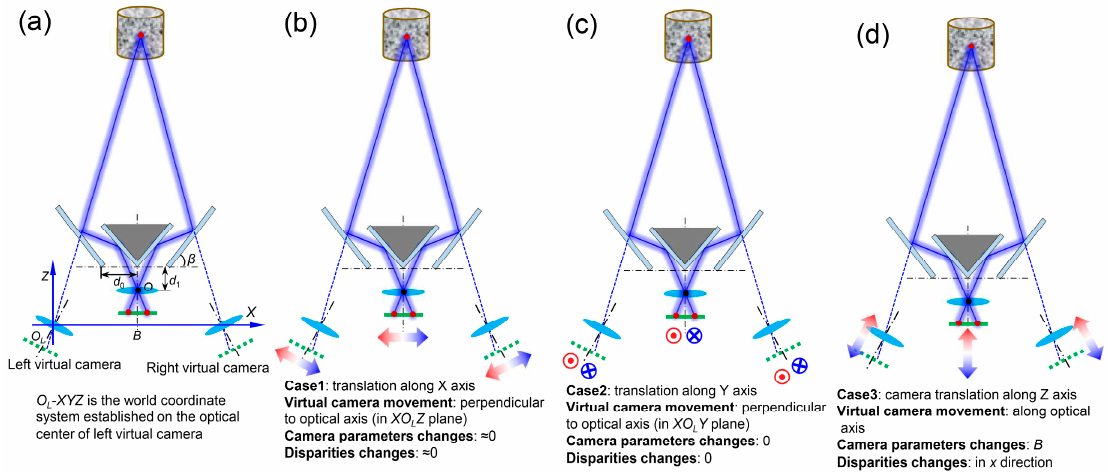
Figure 7. ( a ) Schematic diagram of the smartphone-based stereo-DIC system and ( b–d ) the three most possible movements of the smartphone.